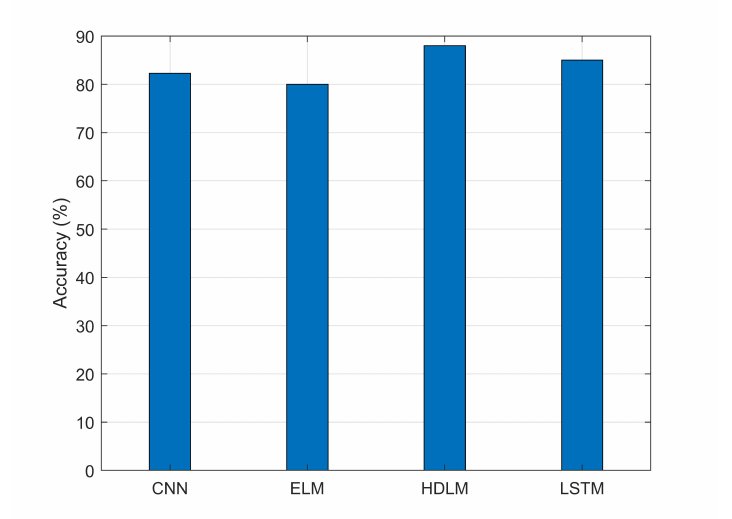
Figure 8. Accuracy comparison of